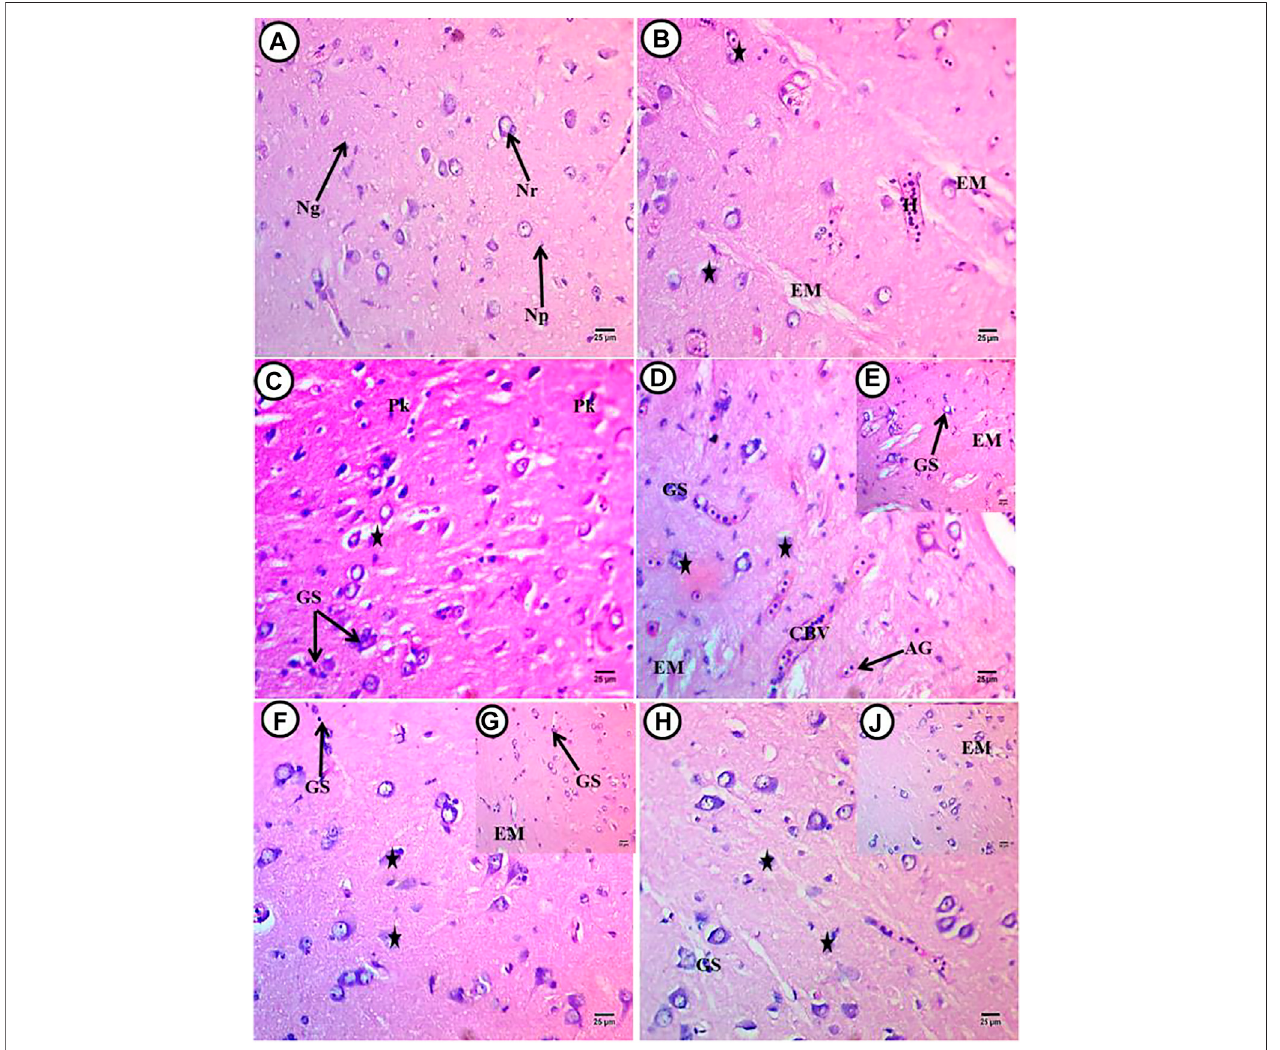
FIGURE 1 | Transverse sections of telencephalon of African cat fi sh ( C. gariepinus ) exposed to PE-MPs and PE-MPs with lycopene, citric acid and chlorella as antioxidants for 15 days. (A) Control fi sh showing normal histology of brain tissue (Telencephalon), Nr; neurons, Np; neuropil and Ng; neuroglial cells, (B,C) (PE-MPs 500 mg/kg diet), (D,E) PE-MPs + lycopene (500 mg/kg diet), (F,G) PE-MPs + citric acid (30 g/kg diet) and (H,J) PE-MPs + chlorella (50 g/kg diet). ( star); diffuse deformed and degenerated neurons, EM; encephalomalacia, GS; aggregated neuroglial cells (gliosis) and edema, H; hemorrhage and in fl ammatory cells, AG; angiogenesis, CBV; congested blood vessels and Pk; pyknotic neurons. H&E. Scale bar 25 µm.